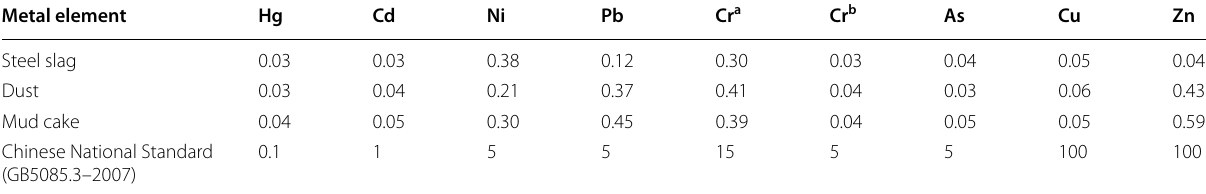
a total content of Cr; b content of Cr (VI)